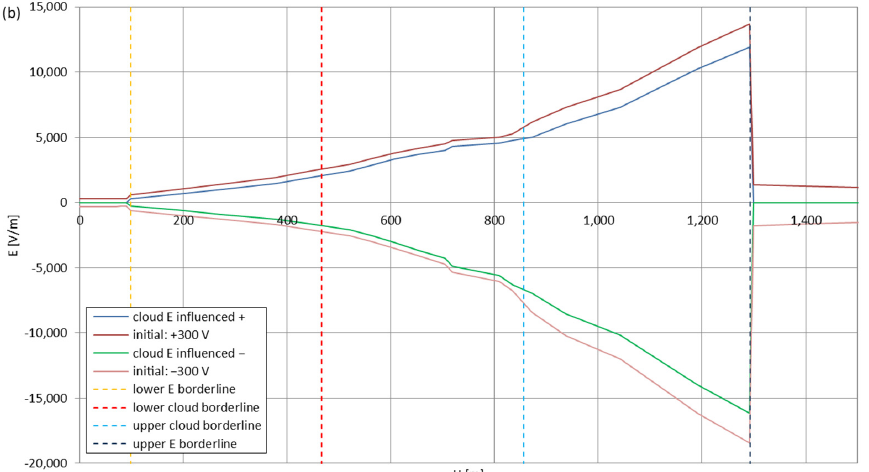
Figure 6. Maximum electric field strengths around the wire antenna passing through Stratocumulus cloud negatively polarized: ( a ) ‘static’ case and ( b ) ‘dynamic’ case.